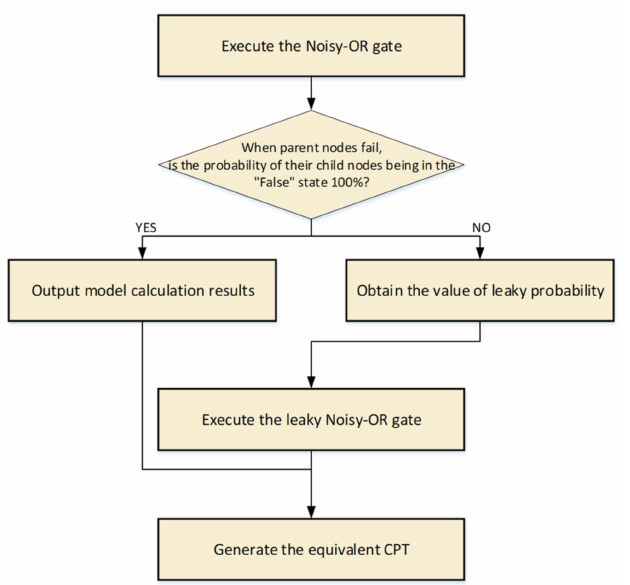
Figure 8. Operational flow chart of the calculation of the equivalent